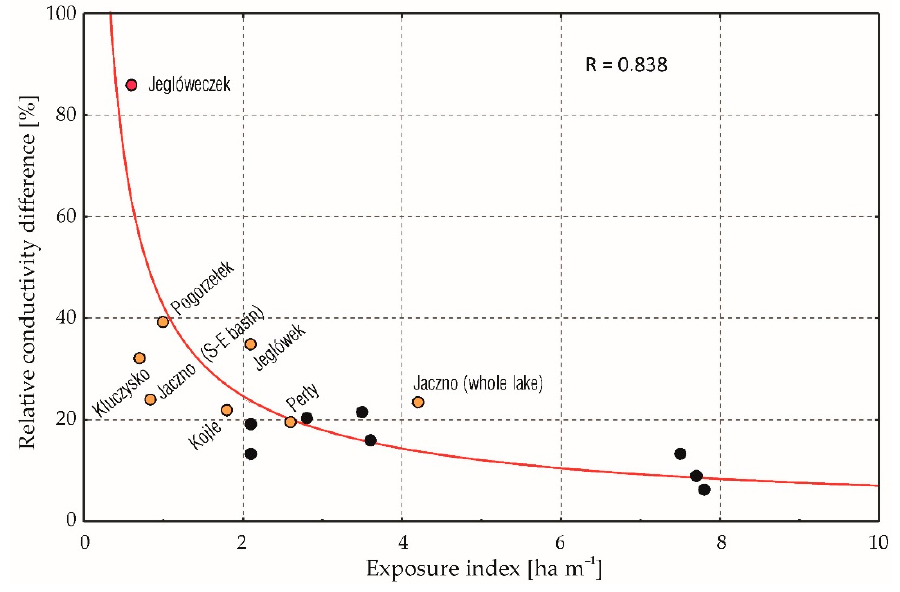
Figure 4. Relationship between maximum conductivity difference along the water column in summer (August) and exposure index determined for 15 SLP lakes. Black circles denote typical dimictic lakes, orange circles denote lakes in transition (dimictic/meromictic), and a red circle denotes a meromictic lake.